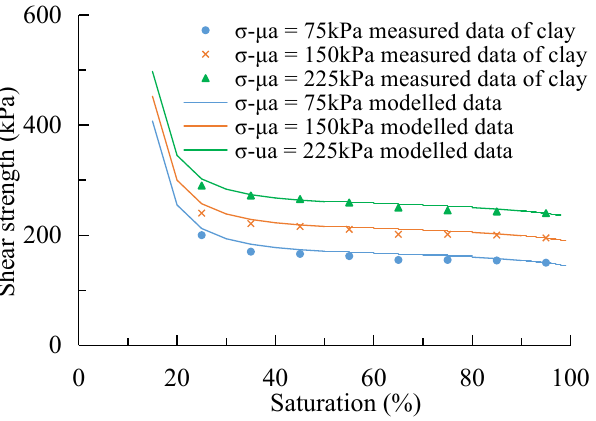
Figure 24. Comparison of the calculated shear strength of the proposed model and the experimental data [27].